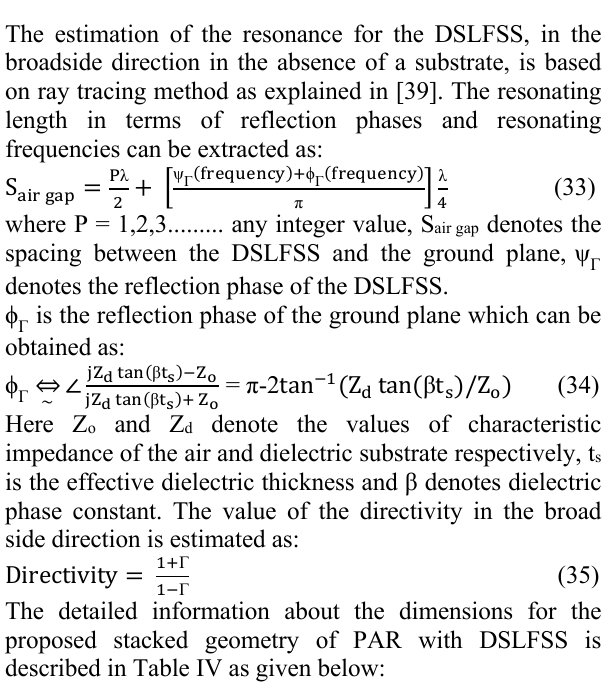
FIGURE 8: Comparative analysis of simulated and measured results of PAR with DSLFSS (a) reflection coefficient, (b) voltage standing wave ratio, (c) gain, and (d) directivity.